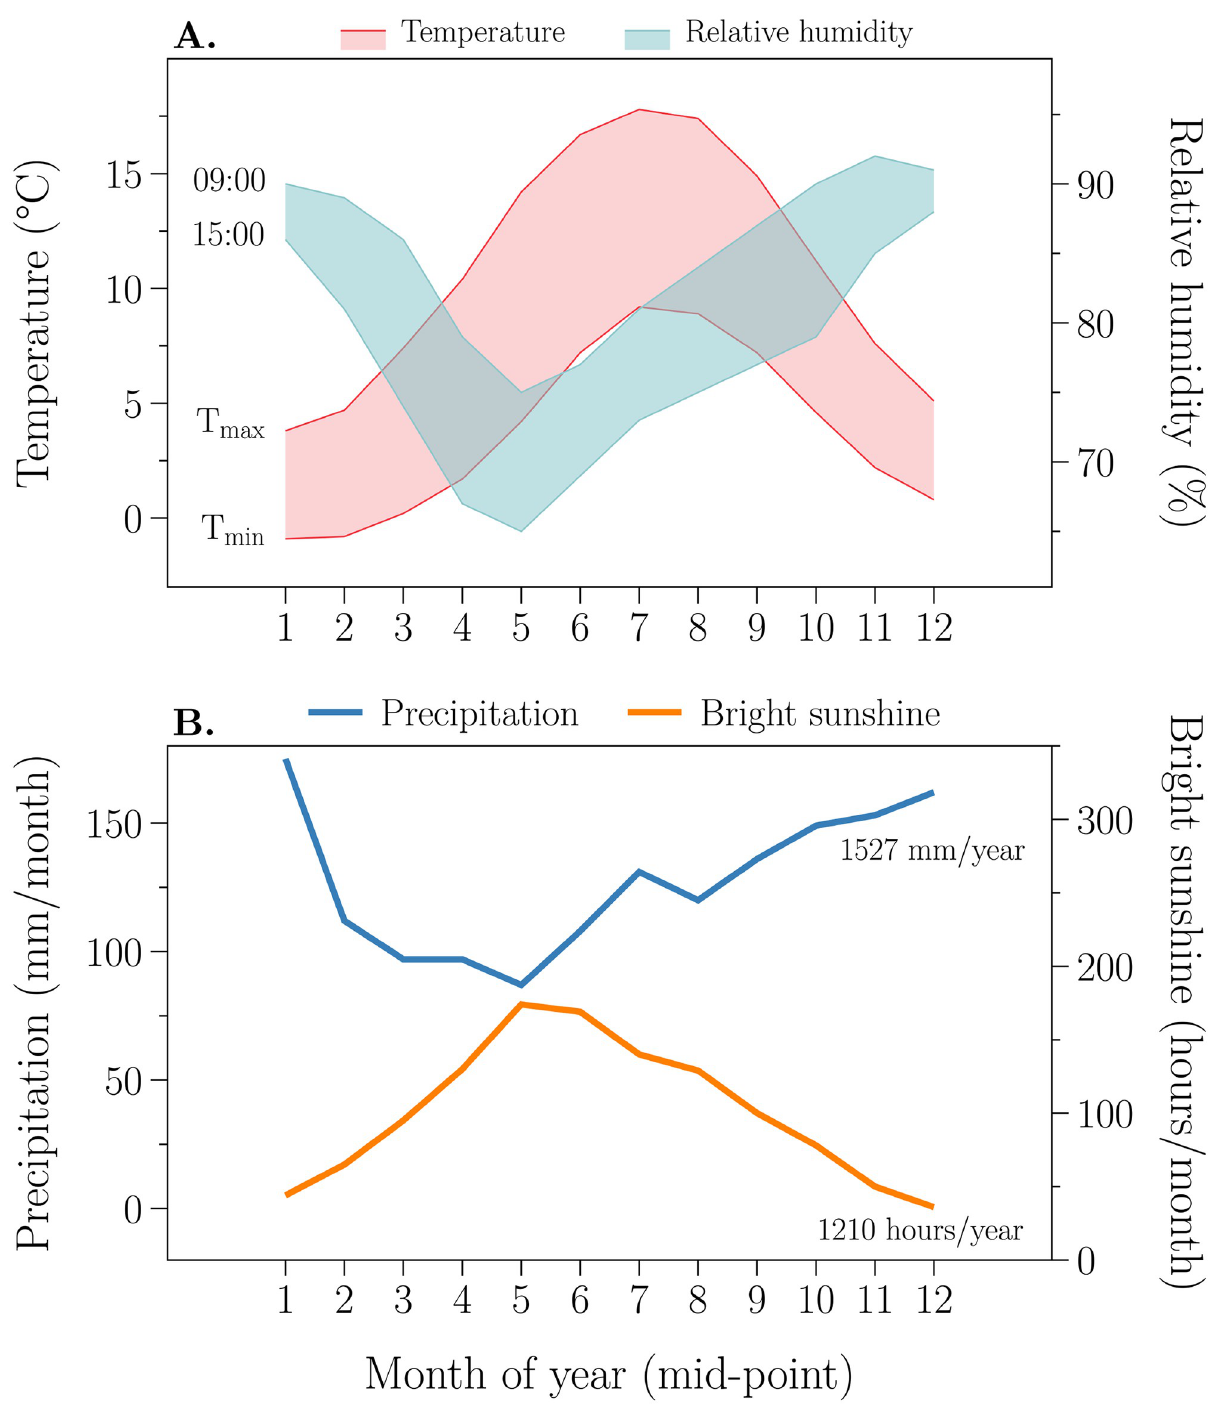
Fig 3. Climate at Eskdalemuir. 30-year monthly means taken from meteorological tables are drawn. See text for details.